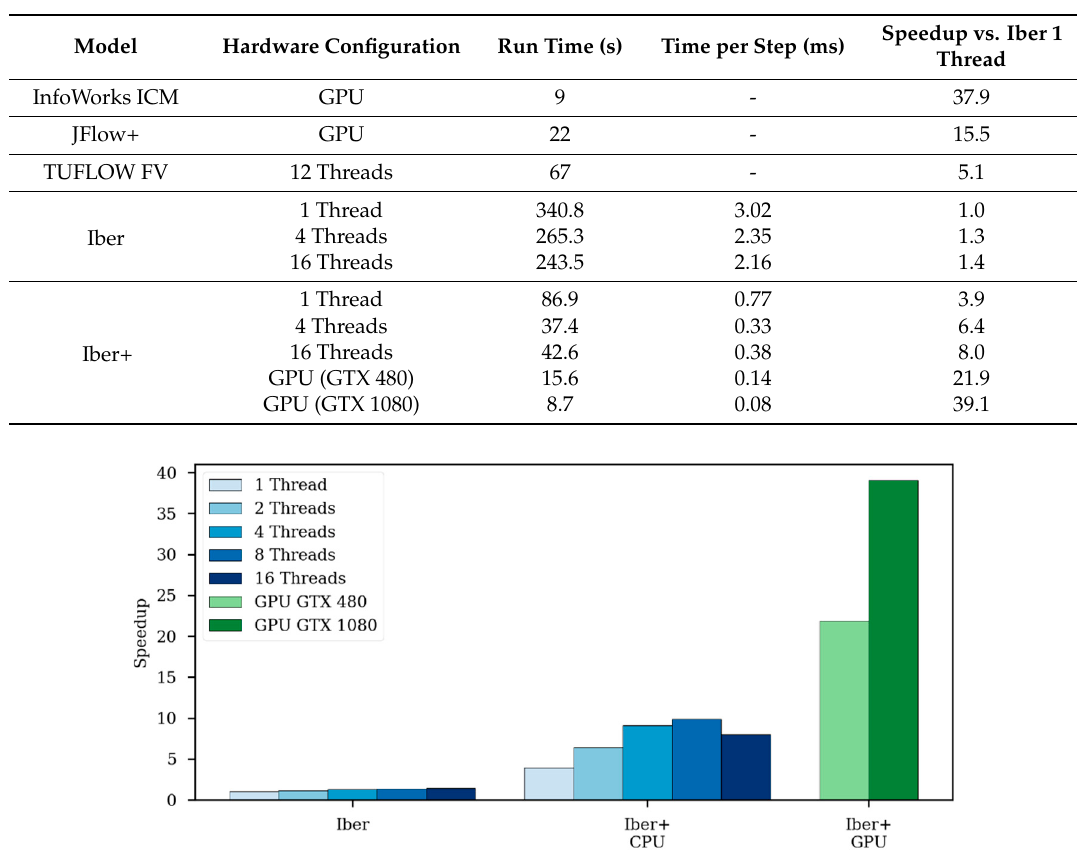
Table 4. Performance measurements for Test 5. Total run time of the simulation in seconds, average processing time per time step in milliseconds and the achieved speedups compared with Iber running in a single thread.